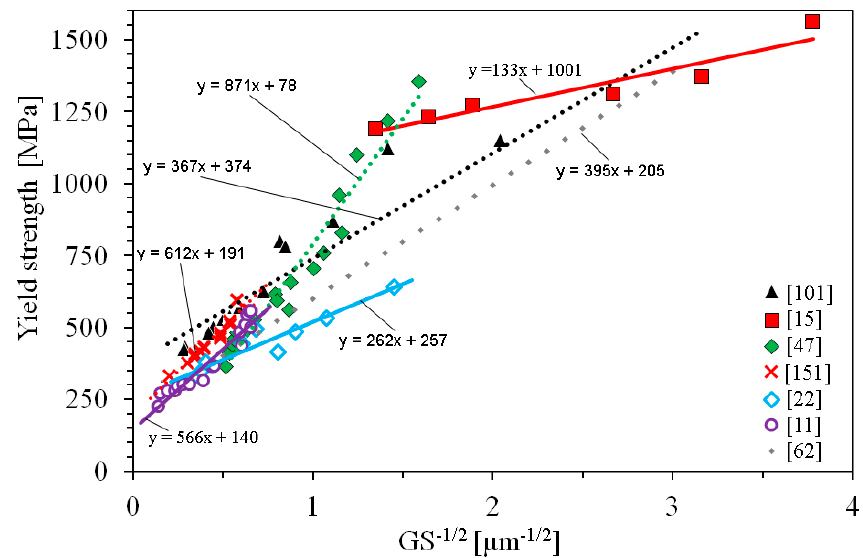
Figure 9. Examples of the Hall–Petch relations presented for reversed structures. Data for annealed coarse-grained 301LN is included from [151].